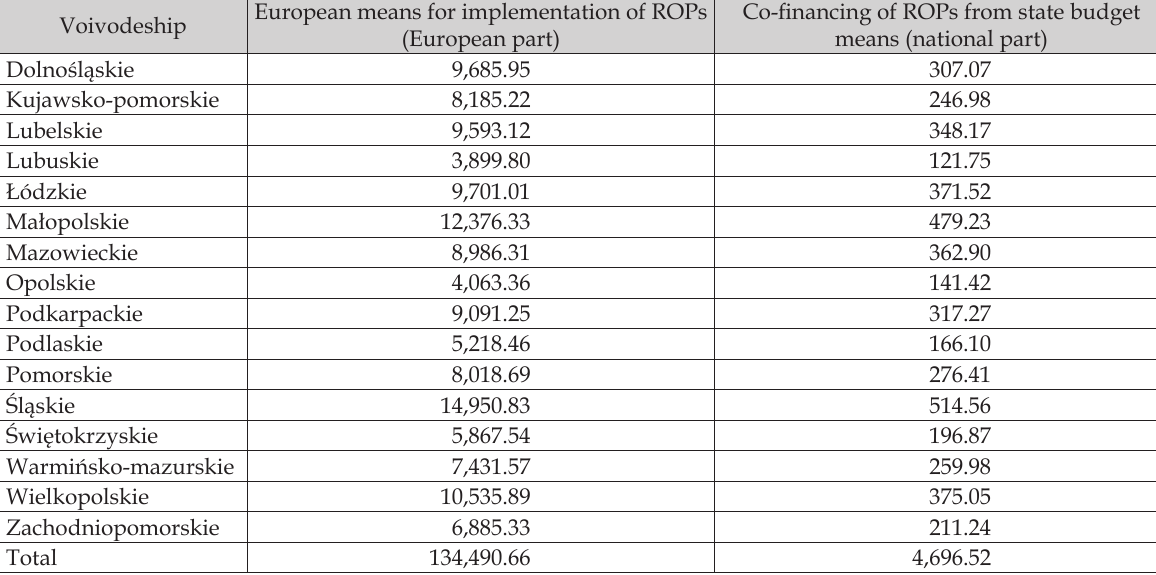
Table 4. Indicative budget of territorial contracts in 2014–2020 (in million